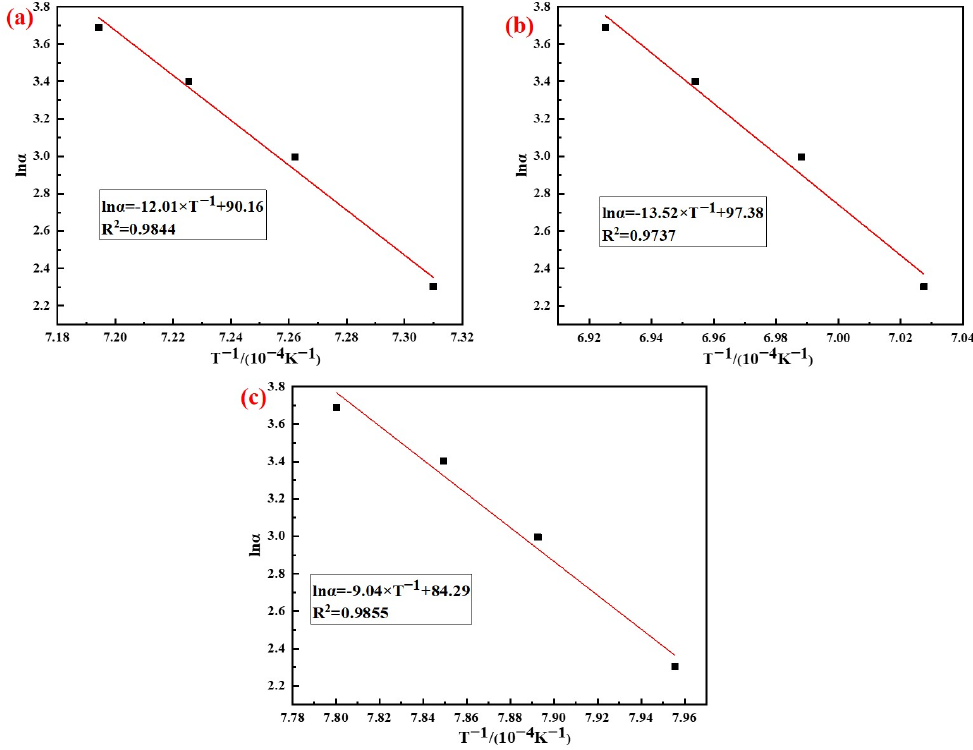
Figure 9. Analysis results of Ozawa method: ( a ) Fly ash; ( b ) Silica dust; ( c ) Gangue.